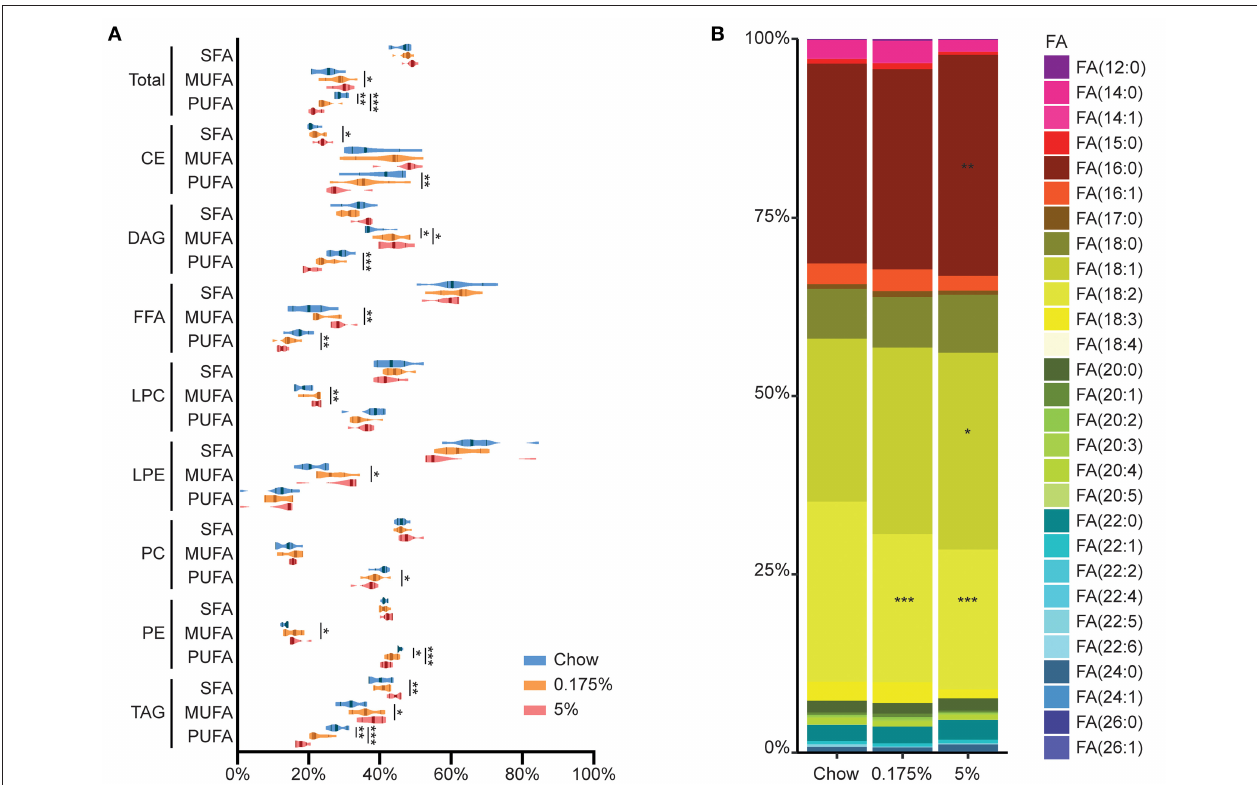
FIGURE 3 | Detailed plasma lipid composition in chow, 0.175% and 5% lard diet groups. (A) . Percentages of SFA, MUFA and PUFA in total lipids and within lipid classes. Violin plot shapes represent value distribution within a group, with median shown by thick line and P25-P75 shown by thin lines. (B) . Representation of fatty acid percentages in total lipids. * P ≤ 0.05; ** P ≤ 0.01; *** P ≤ 0.001 vs.